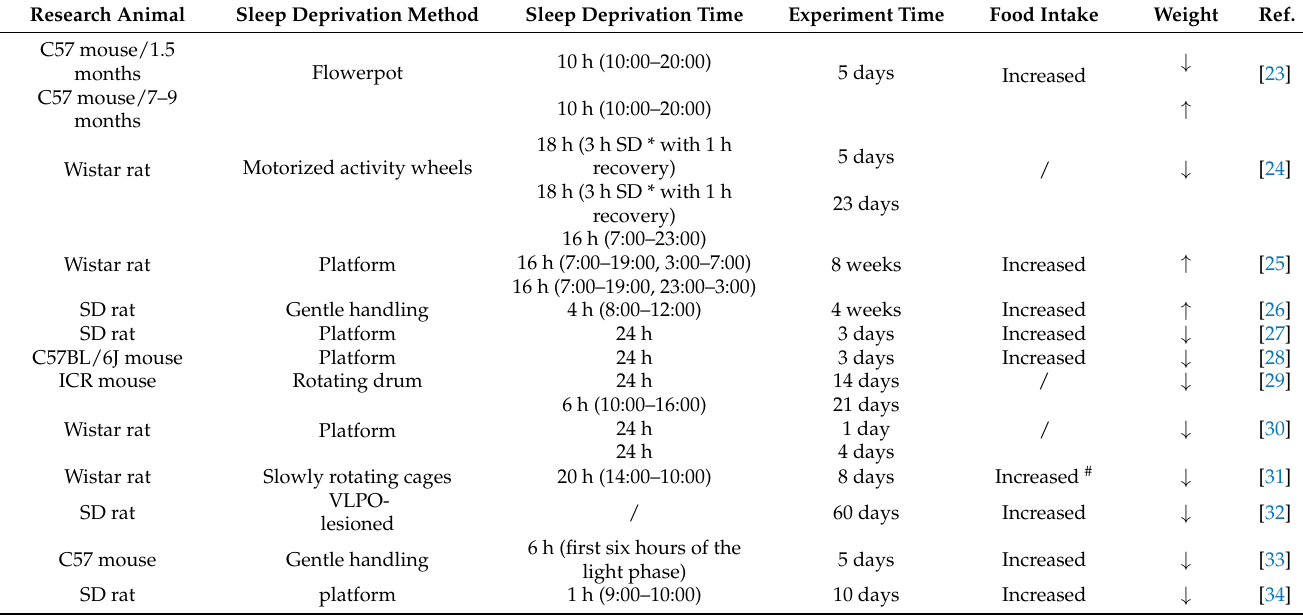
Table 1. Animal models of sleep